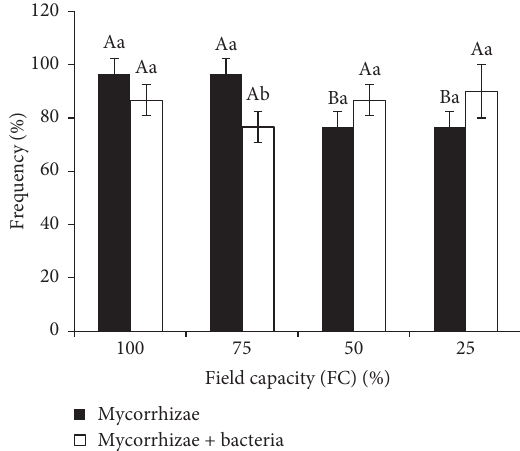
Figure 2: The frequency of colonization in mycorrhizae and mycorrhizae +bacteria plants under water deficit conditions. Vertical bars represent the standard deviation ( n � 3). Bars with different lowercase letters indicate significant differences between treatments at the same FC ( p < 0 . 05). Bars with different uppercase letters indicate significant differences in the same treatment at different FC percentages ( p < 0 .